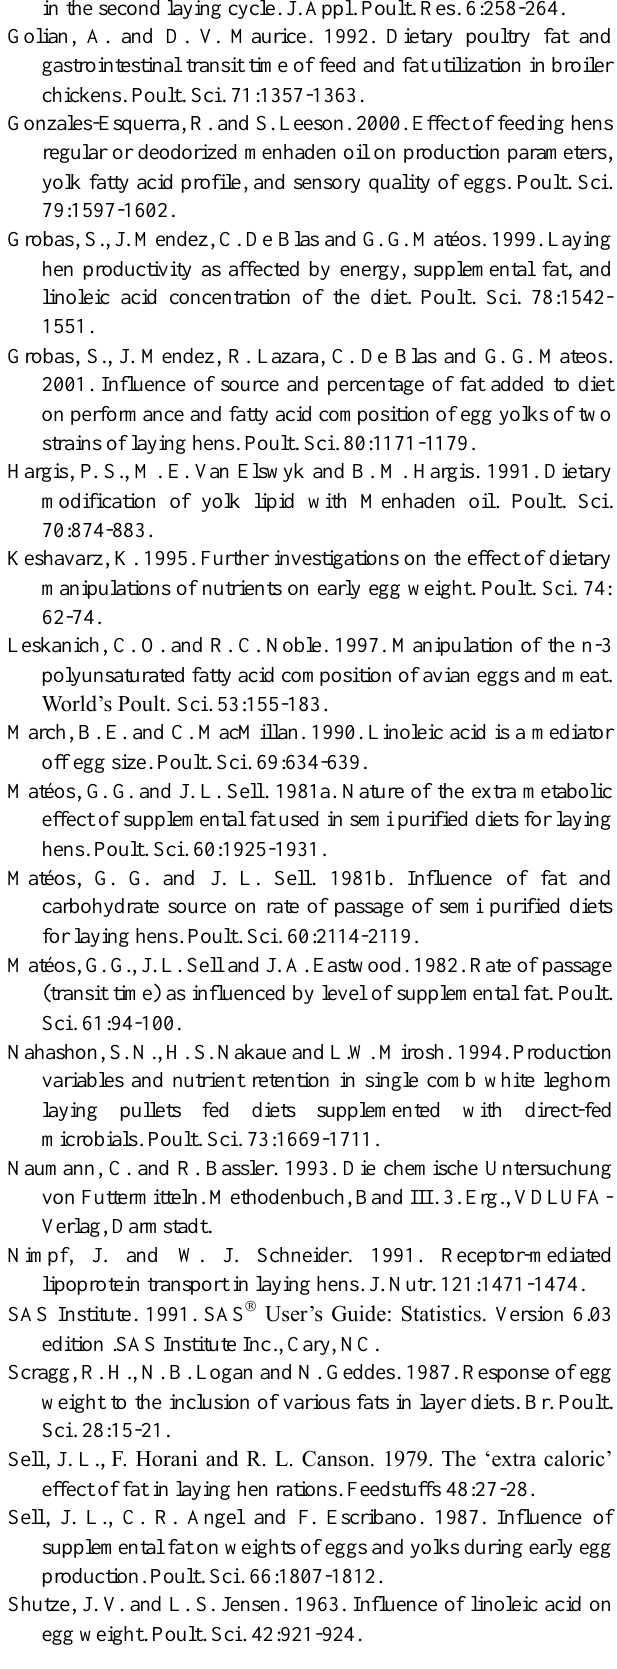
Table 5. Absolute and percentage weight of liver and abdominal fat of SFAT-fed hens